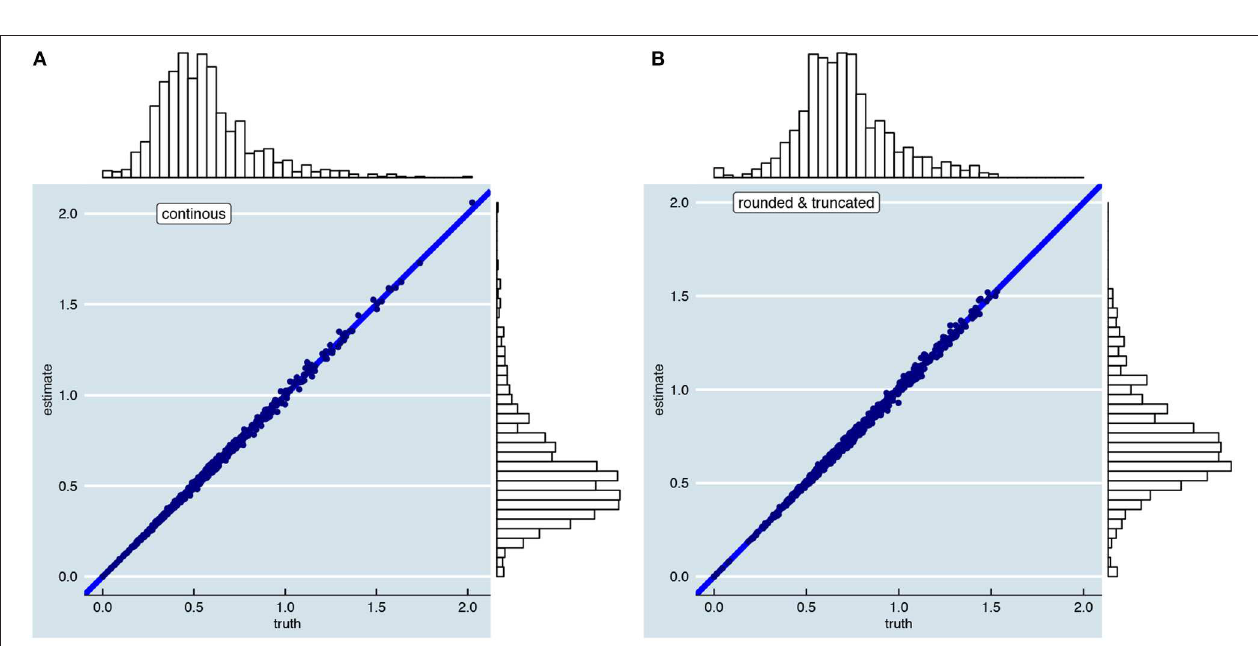
FIGURE 9 | When the parallel test scores are truncated and rounded, the relationships between “true” scores and error variances as depicted in Figure 5 change. In the extreme case, when there are only 12 items and K = 12, the relationship between “true” scores and error variances of an originally quadratic increase (A) , quadratic decrease (B) , flat relationship (C) and linear decrease (D) all more or less reassemble that of the red parabola, which corresponds to the binomial error of a 12-item, dichotomously scored test.